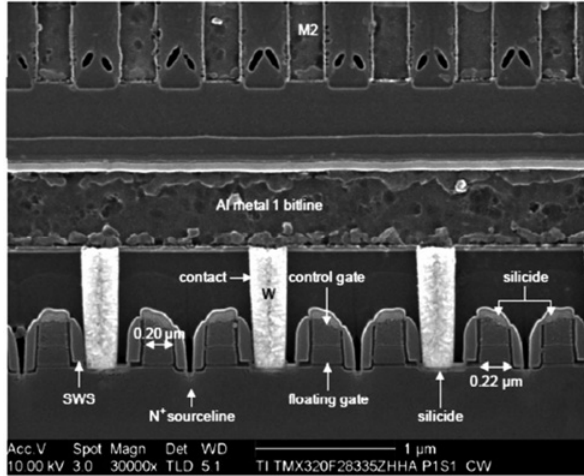
Figure 5: SEM cross-sectional image of the Texas Instruments- based NOR flash memory showing the transistors. The control and the FGs along with the silicide and metal layers have been